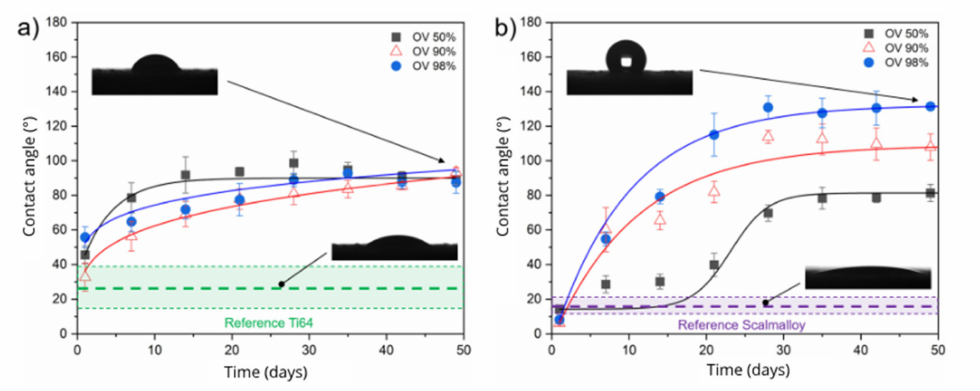
Figure 5. Temporal trend of static water contact angles (WCA) for DLIP modified ( a ) Ti64 and ( b ) Scalmalloy ® specimens depending on the pulse overlap (OV = 50%, 90% and